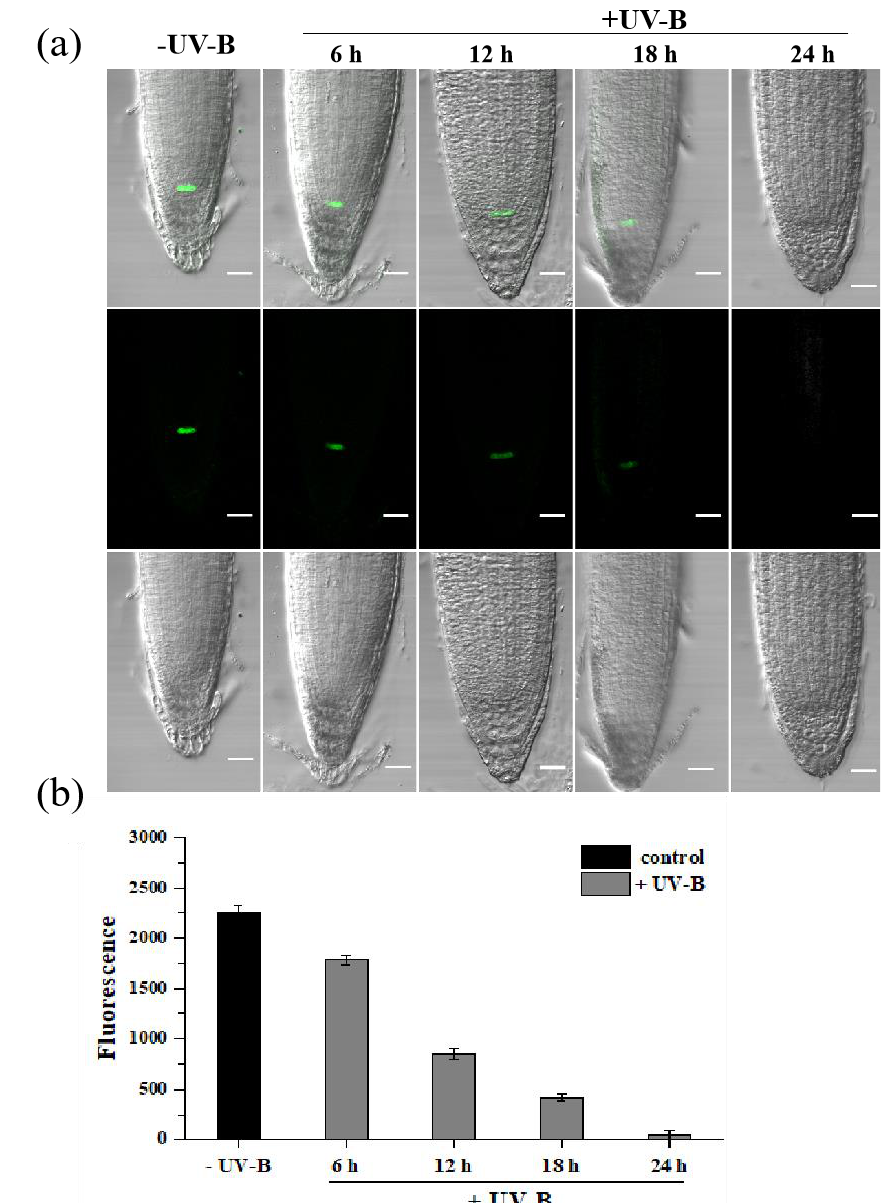
Figure A5. Effects of enhanced UV-B radiation on A. thaliana seedlings ( PWOX5 ∷ GFP ) primary root tip quiescent center cells. PWOX5 ∷ GFP is a green fluorescent protein expression line driven by the quiescence center-specific expression gene WOX5 promoter . Scale bars represent 30 μm. ( a ) Green fluorescence of quiescent center cells at 6 h, 12 h, 18 h and 24 h after UV-B radiation. ( b ) Relative quantitative analysis of green fluorescence intensity.